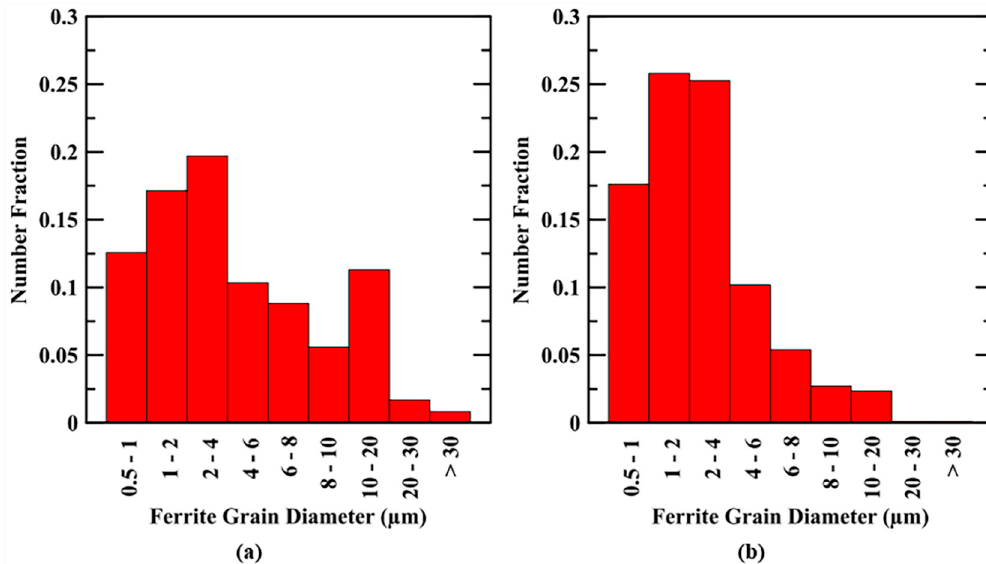
Figure 16. Ferrite grain diameter histograms obtained with EBSD analysis of the polygonal ferrite microstructures produced via ( a ) High T Finish and ( b ) Low T Finish simulations followed by isothermal holding at 650 °C for 30 min. Data were obtained at the 0.724 radial position for both.